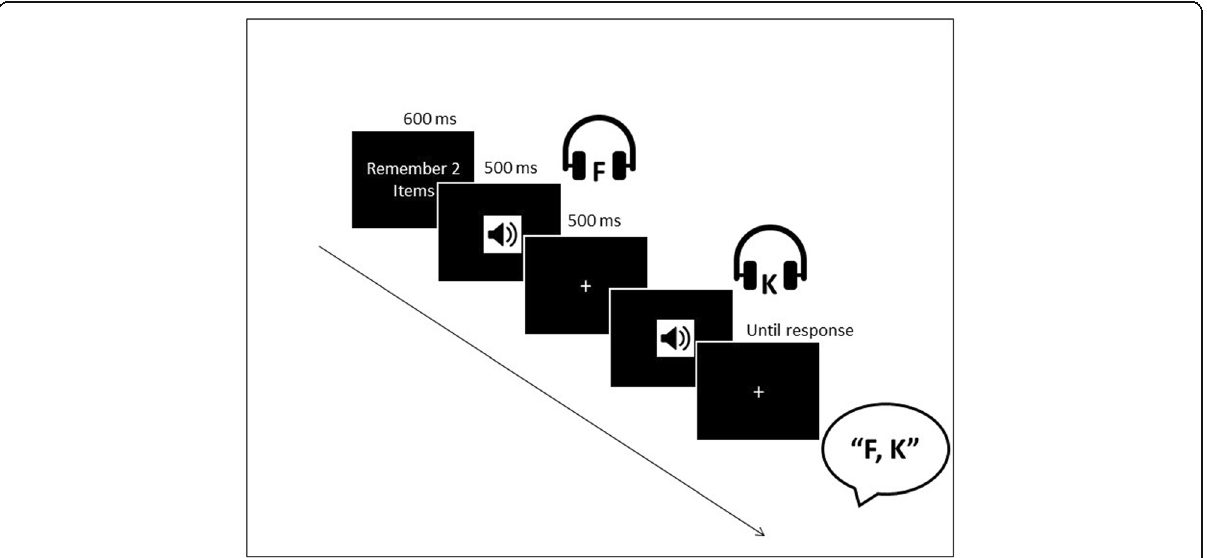
Fig. 1 Schematic of the trial sequence for a sample trial of the short-term memory